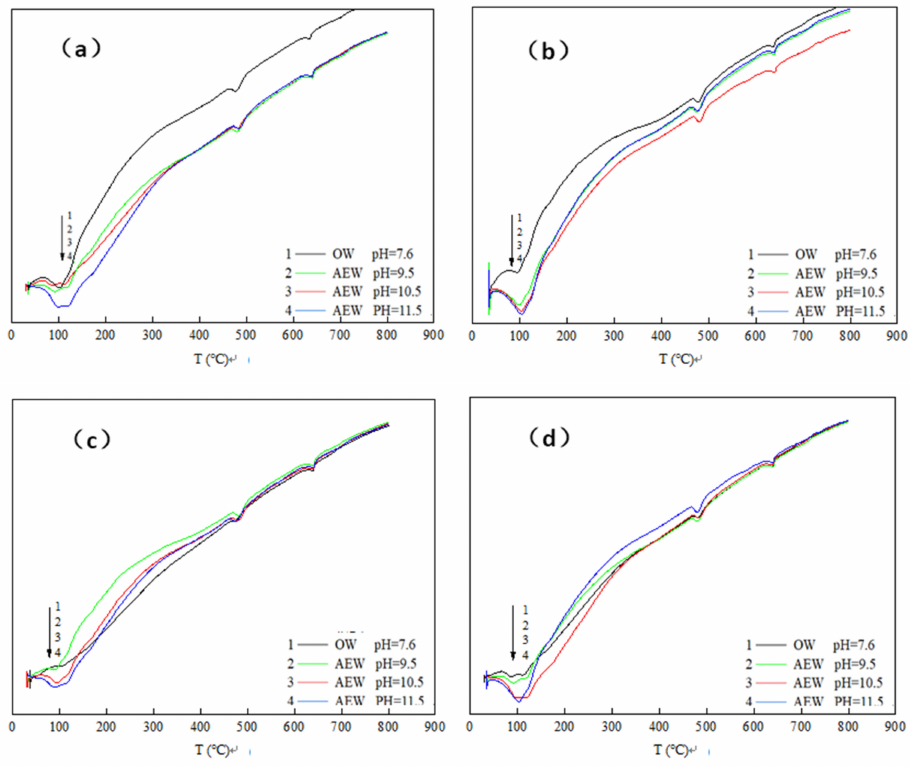
Figure 8. DTA curve of cement paste at 3d: ( a ) FA = 0; ( b ) FA = 15%; ( c ) FA = 30%; ( d ) FA = 45%.